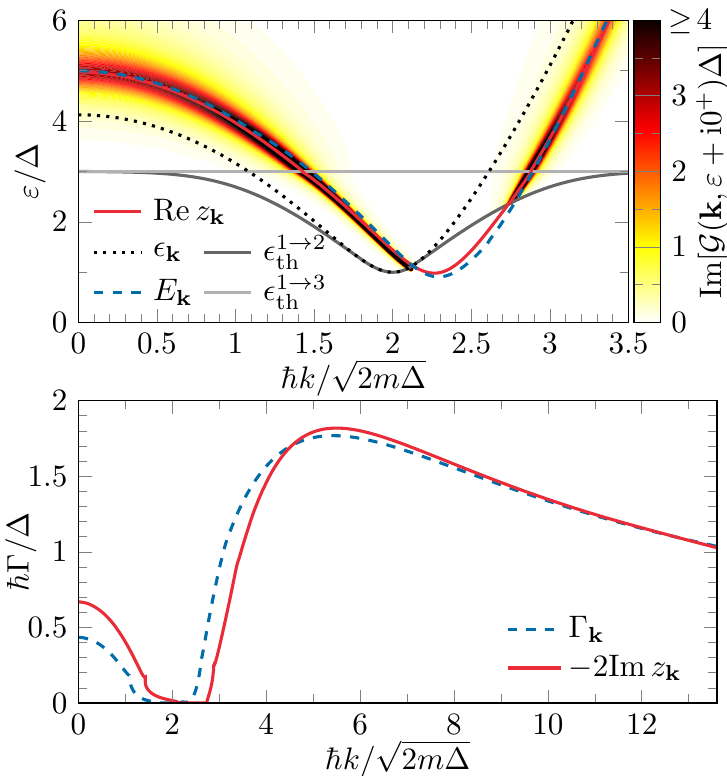
a (cid:39) − 0.9). Figure 5: Quasiparticle spectrum in the BCS regime ( µ/ ∆ = 4, 1 / k F ( k , (cid:34) + i0 + )] is shown as a function of the The quasiparticle spectral density Im [ G wavenumber k and energy (cid:34) in units of the order parameter ∆ . This is compared to the self-consistent energy (red line found by solving Eq. (38) in the undamped region, and by fitting the Green’s function to Eq. (40) elsewhere), the perturbative energy given by Eq. (39) (blue dashed line), and the mean-field energy (black dotted line). The threshold energies ε 1 → 2 (dark grey) and ε 1 → 3 (light grey) are also shown th th to distinguish the different regions of possible resonances. In the lower panel, the imaginary part of the eigenenergy is plotted, showing the damping rate of the quasi-